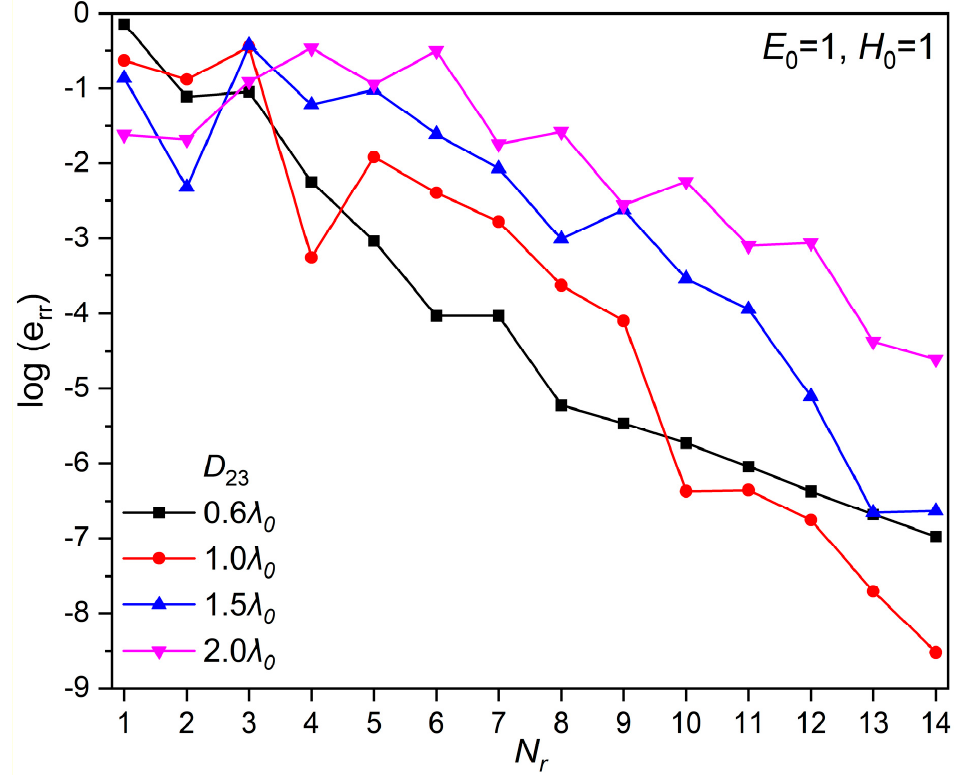
Figure 12. Convergence curves of magnitude error, with E rr given by Equation (15), for the inset structure of Figure 5, arising from that of Figure 1 when E 0 = 1, H 0 = 1, θ (cid:48) = 30 ◦ , ϕ (cid:48) = 60 ◦ , L = 3, ε 1 = ε 0 ,